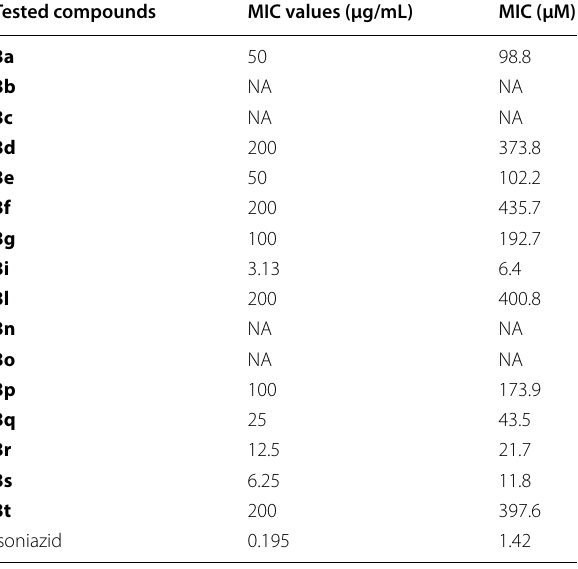
Table 1 The inhibitory activities of the synthesized com- pounds against Mycobacterium tuberculosis Sample code